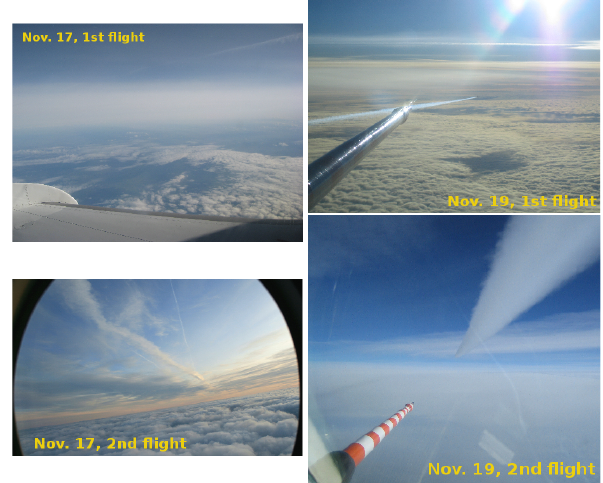
Fig. 7 for the two measured size intervals: the smaller ice crystals, R ice = 1.5–18 µm (FSSP), are shown in the top panel and the larger > 50 µm (CPI) in the bottom